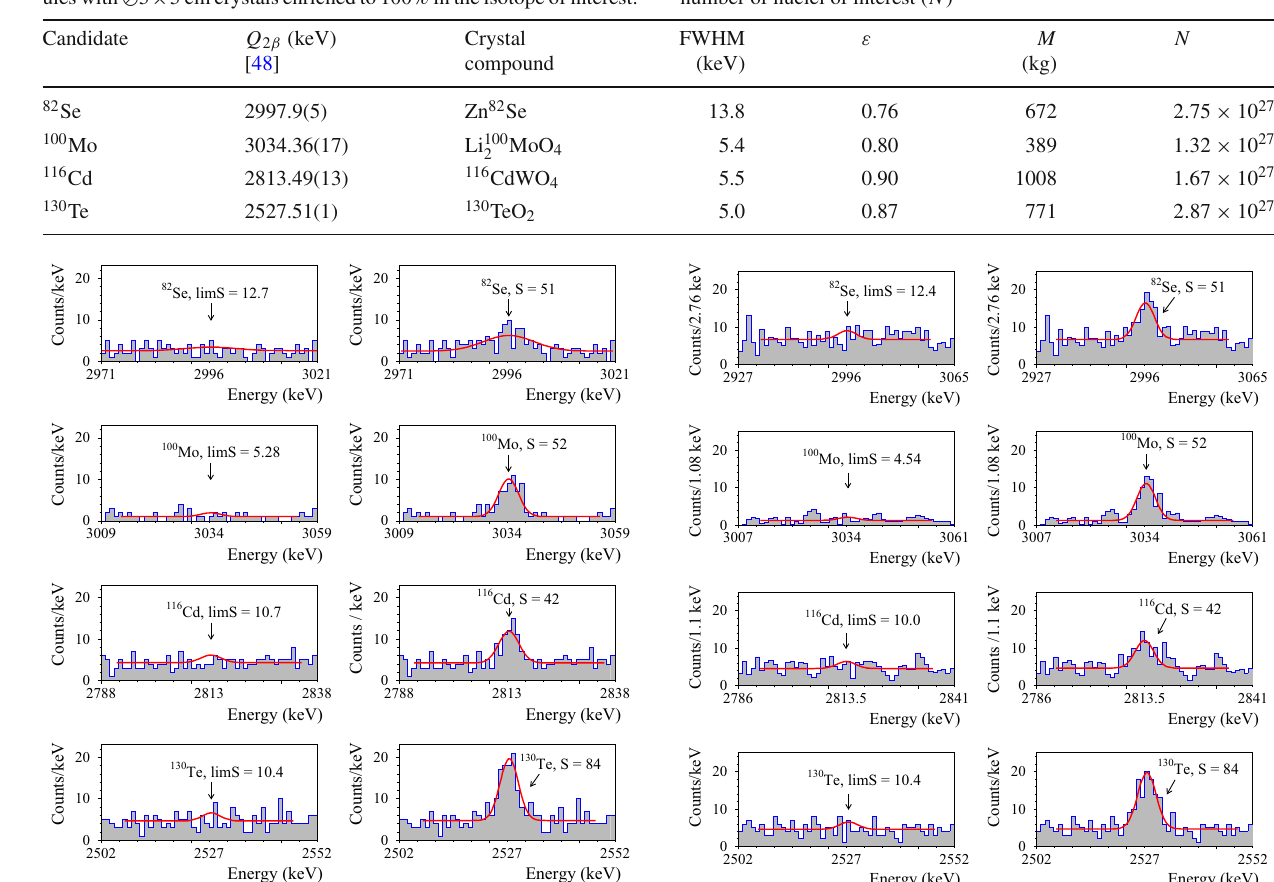
Table 1 Characteristics of a possible CUPID set-up with 82 Se, 100 Mo, 116 Cd and 130 Te in the CUPID-1 option assuming 1300 detector mod- ules with (cid:7) 5 × 5 cm crystals enriched to 100% in the isotope of interest.